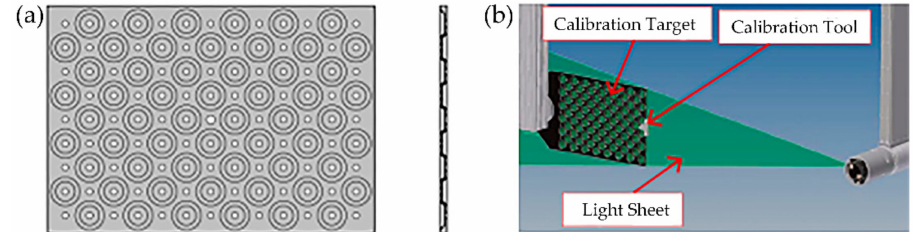
Figure 8. The calibration configuration: ( a ) the multilevel dot matrix and ( b ) the calibration